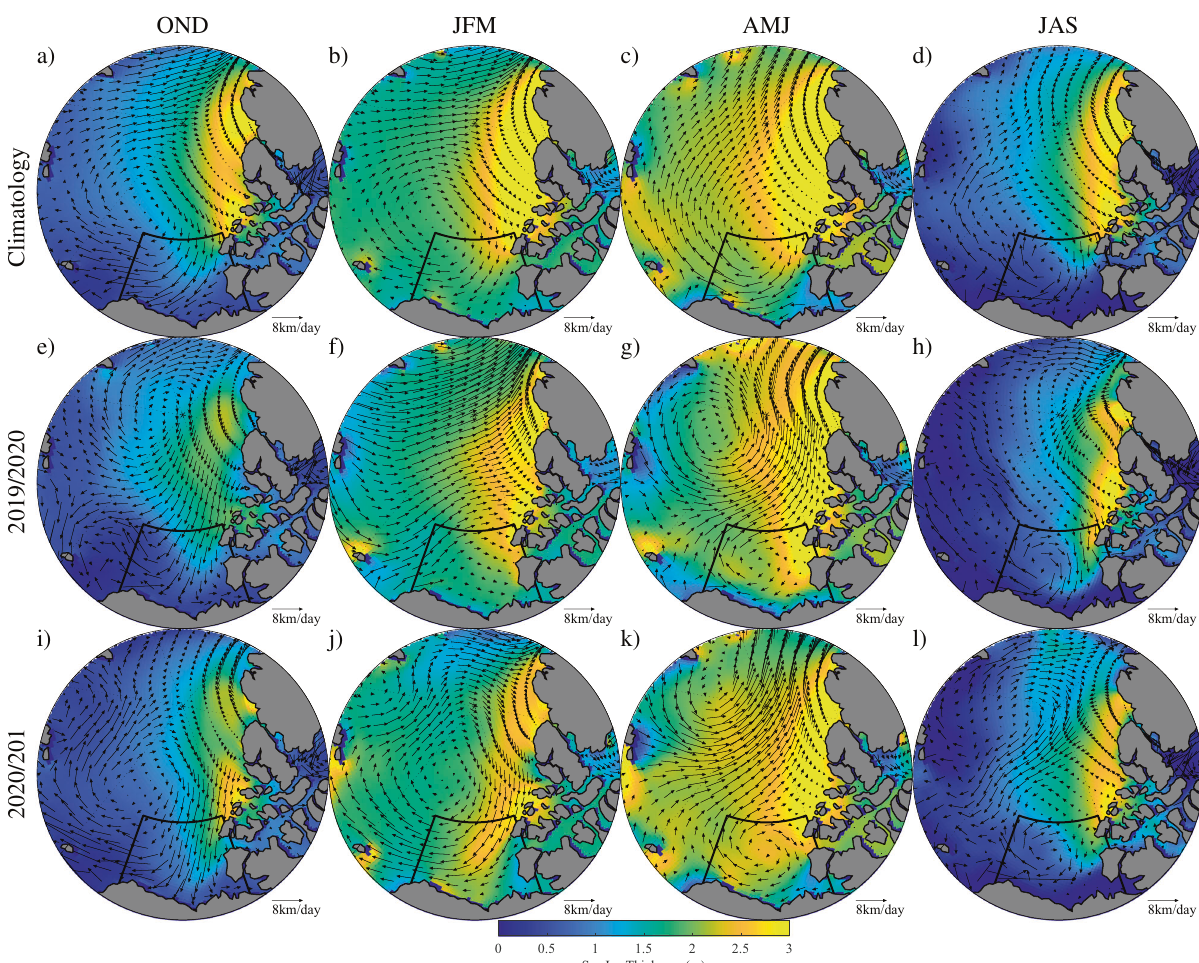
Fig. 5 Annual cycle in seasonal mean (OND: October – December; JFM: January – March; AMJ: April – June; JAS: July – September) sea ice thickness (shading - m) and sea ice motion (vectors- km/day). Results are shown for climatology ( a – d ) as well as 2019/2020 ( e – h ) and 2020/2021 ( i – l ). The polygon indicates the region along the Beaufort Coast over which statistics were computed. All fi elds are from